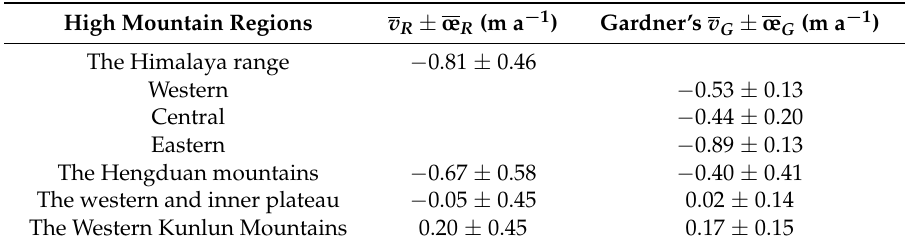
Table 6. Mean glacial thickness change rates per mountain region on the Tibetan Plateau, compared to the results of Gardner et al. (2013)